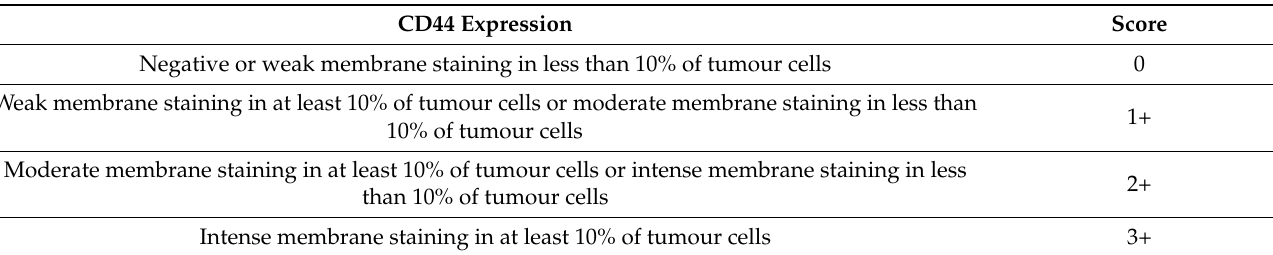
Table 1. CD44 scoring